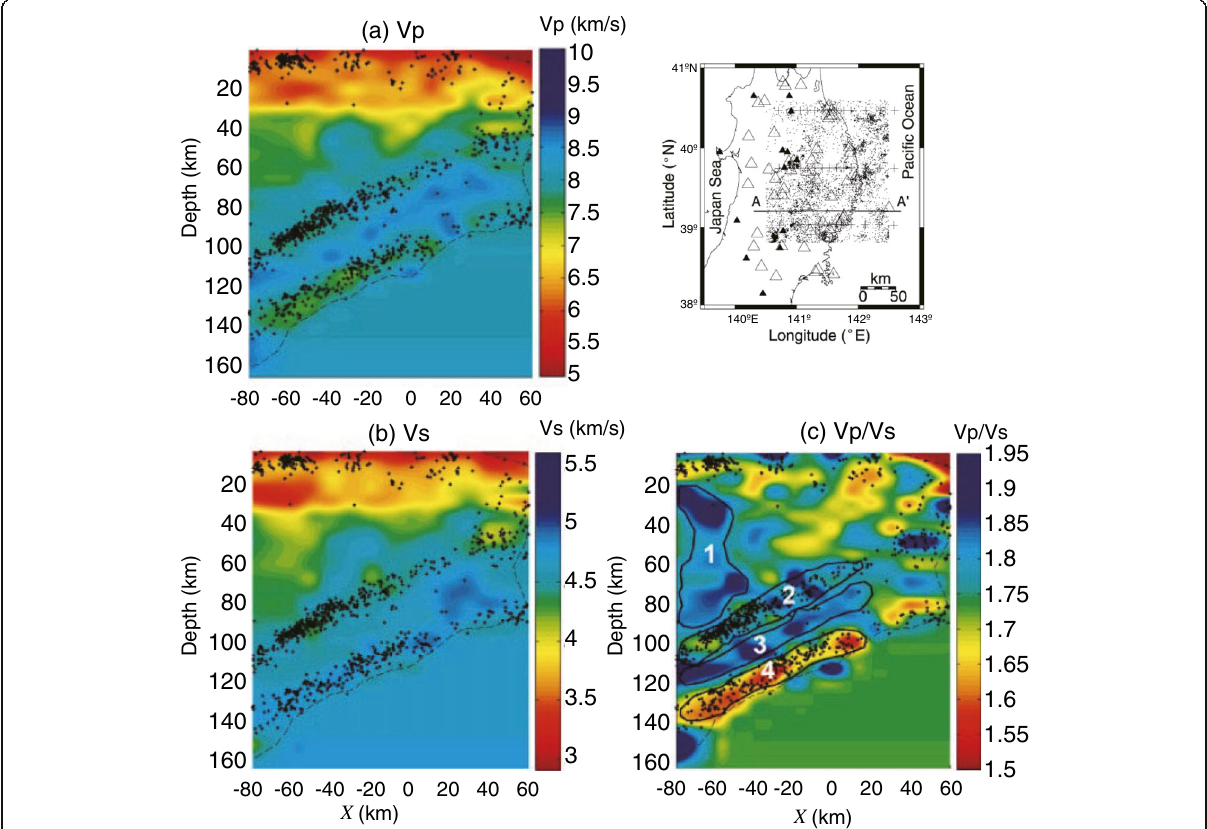
Fig. 19 Seismic velocity structure along the lower seismic plane under central Tohoku. Shown are across-arc vertical cross-sections of a P-wave velocity (Vp), b S-wave velocity (Vs), and c Vp/Vs ratio under central Tohoku. P-wave velocity, S-wave velocity, and Vp/Vs ratio along the line in the inset map are shown by the color scale at the right of each figure. Black dots are earthquakes. (After Zhang et al.